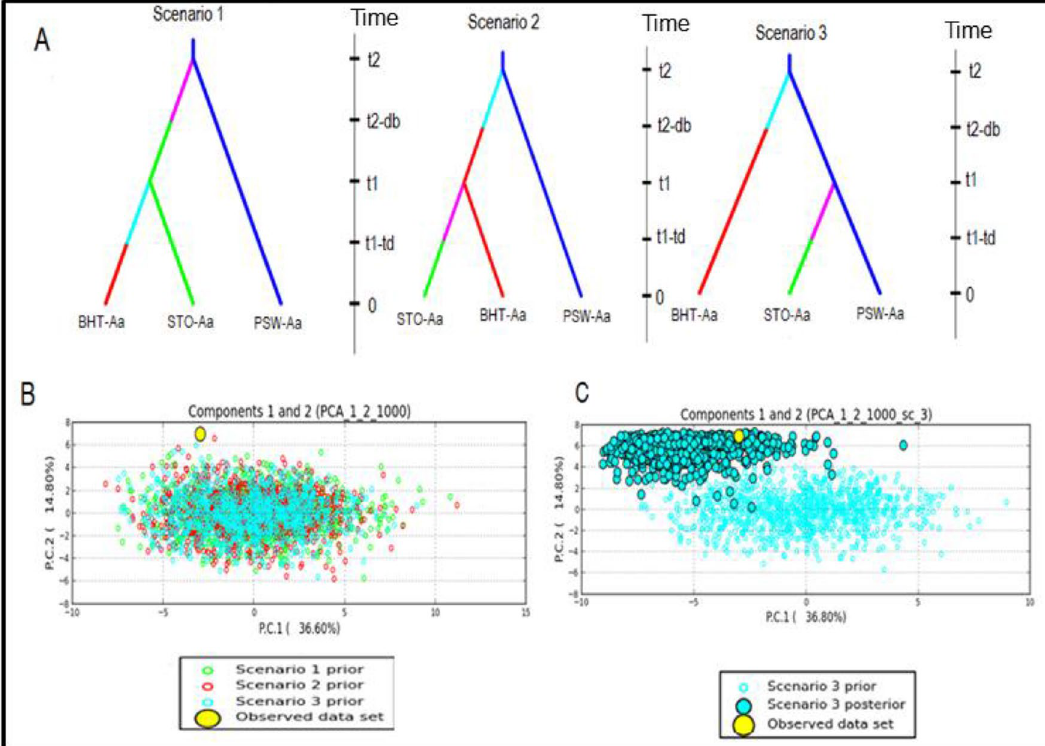
Figure 7. Scenarios were tested using DIYABC analysis to infer the demographic history of Alternaria alternata in North Carolina using 220 single nucleotide polymorphisms (SNPs) from 10 microsatellite loci. The three scenarios reflect the probable hypotheses of population isolation between the geographic populations in North Carolina. Scenario 1: PSW-Aa originates from an unknown ancestral population. STO-Aa originates from an unknown ancestry and gives rise to BHT-Aa. Scenario 2: PSW-Aa originates from an unknown ancestral population. BHT-Aa originates from an unknown ancestral population and gives rise to STO-Aa. Scenario 3: PSW-Aa originates from an unknown ancestor and gives rise to BHT-Aa and STO-Aa (best scenario) ( A ). Posterior probability values are based on logistic regression of all three scenarios ( B ). Validation of the prior choices of best scenario 3 using principal coordinate analysis based on summary statistics considering 1000 random simulated datasets ( C